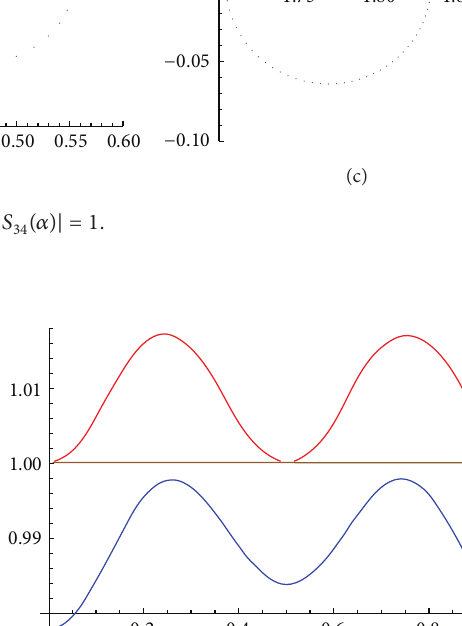
Figure 8: Stability function of the 2-cycle {𝑧 1 (𝛼),𝑧 2 (𝛼)} on 𝐶 1 and 𝐶